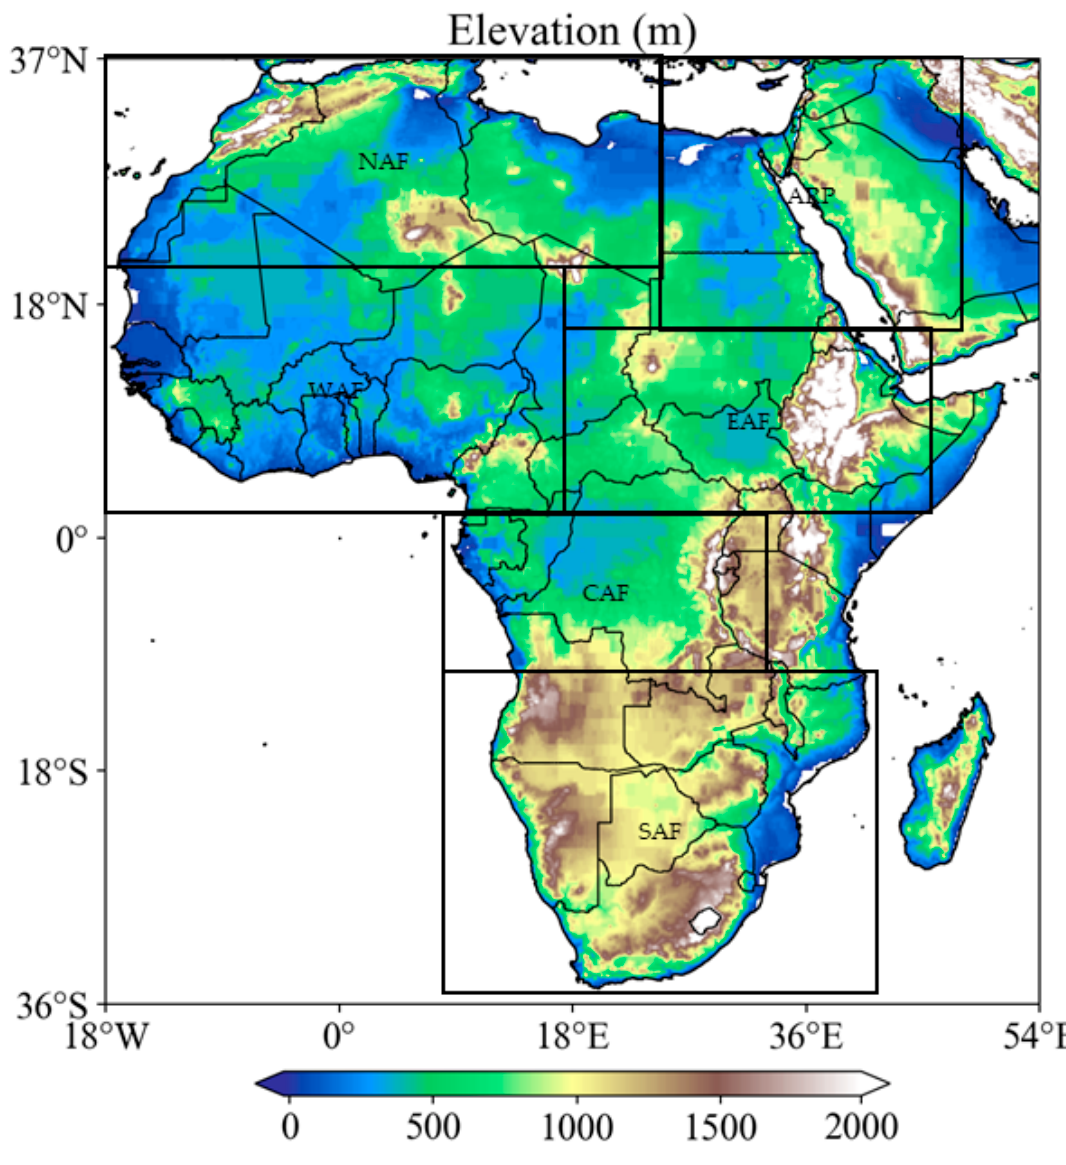
Figure 1. Digital elevation model (DEM) of the African continent and Arabian Peninsula.